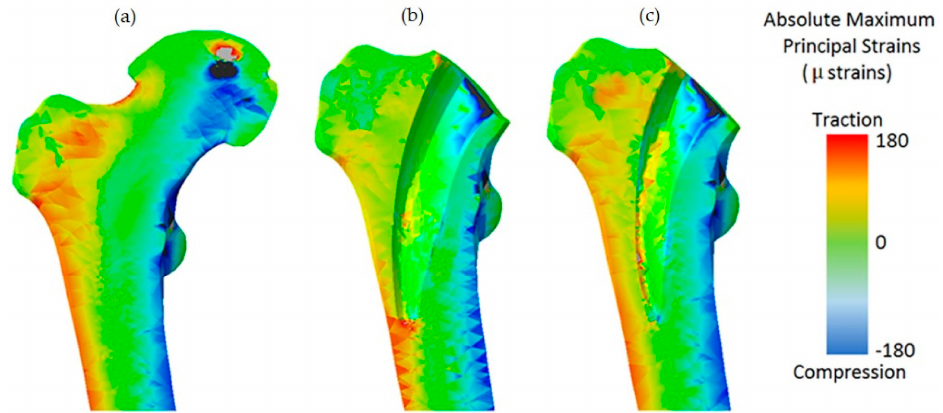
Figure 3. ( a ) Comparison of the absolute maximum principal strain distribution between the intact bone model, ( b ) the one implanted with the original stem, and ( c ) the new design (Adapted with permission from Cilla et al., 2017).[37].